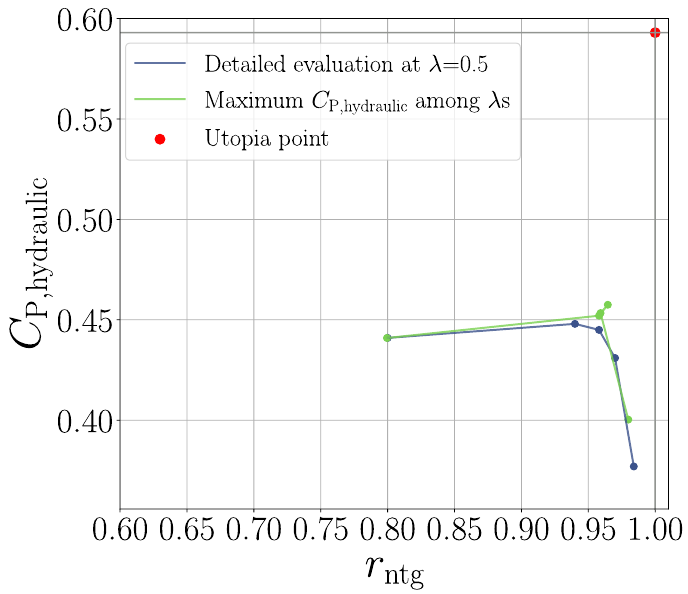
Figure 10. Performance of the top-five (Pareto-optimal) individuals, selecting evaluations with maximum C P , hydraulic among different values of λ for each case. Note that the scales of both axes do not start at zero, focusing on the high-efficiency